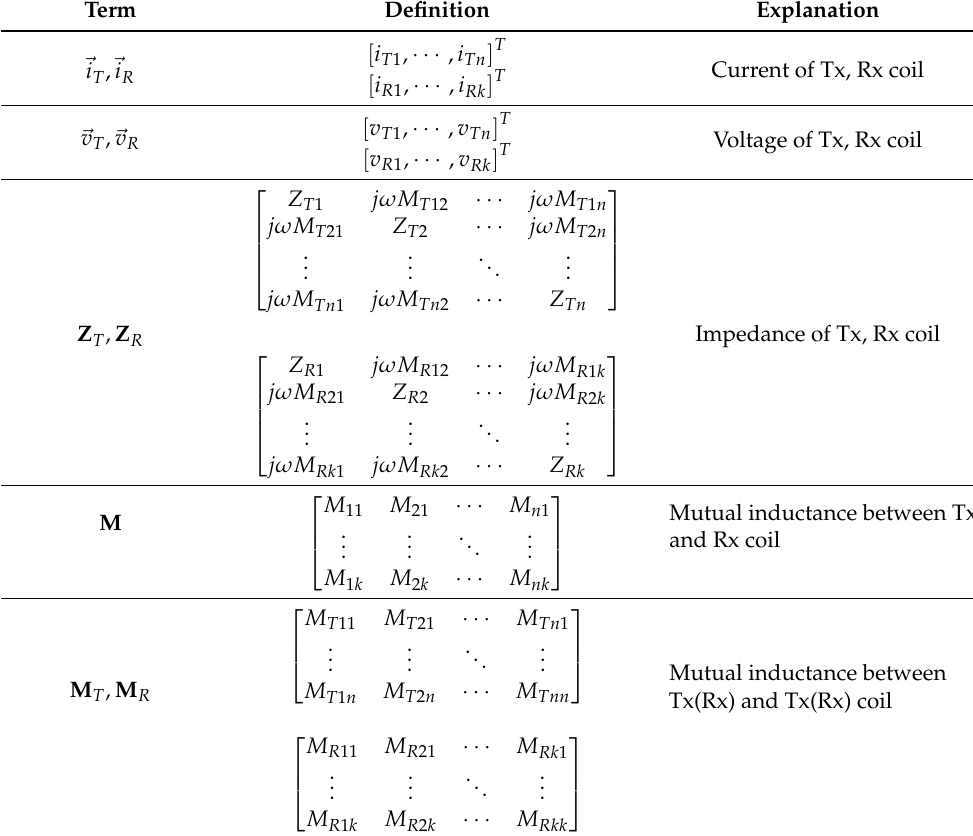
Table 1. The definition of vector and matrix.